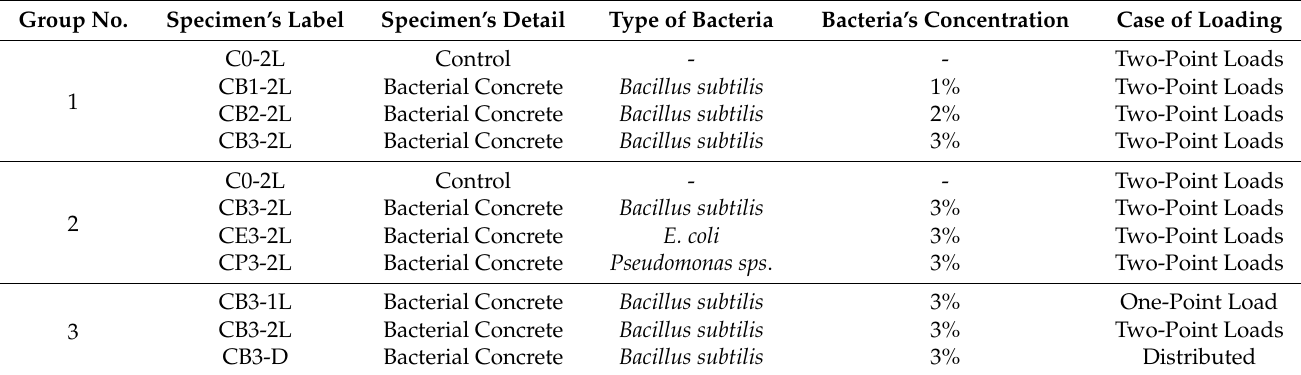
Table 2. Description of ANSYS Models for Parametric Study.